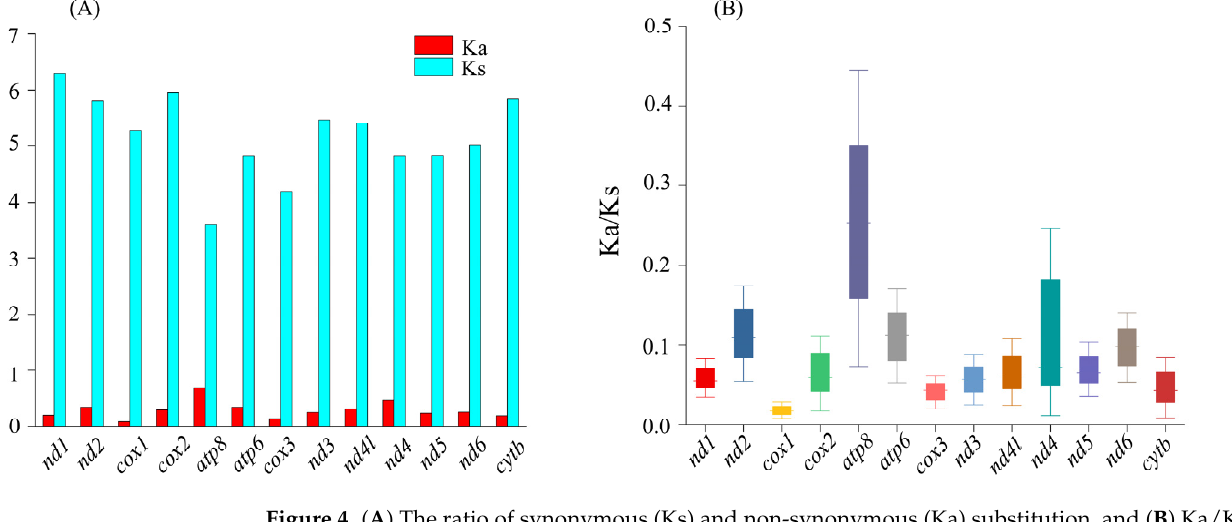
Figure 4. ( A ) The ratio of synonymous (Ks) and non-synonymous (Ka) substitution, and ( B ) Ka/Ks of 13 PCGs among 21 species within Megophryidae.